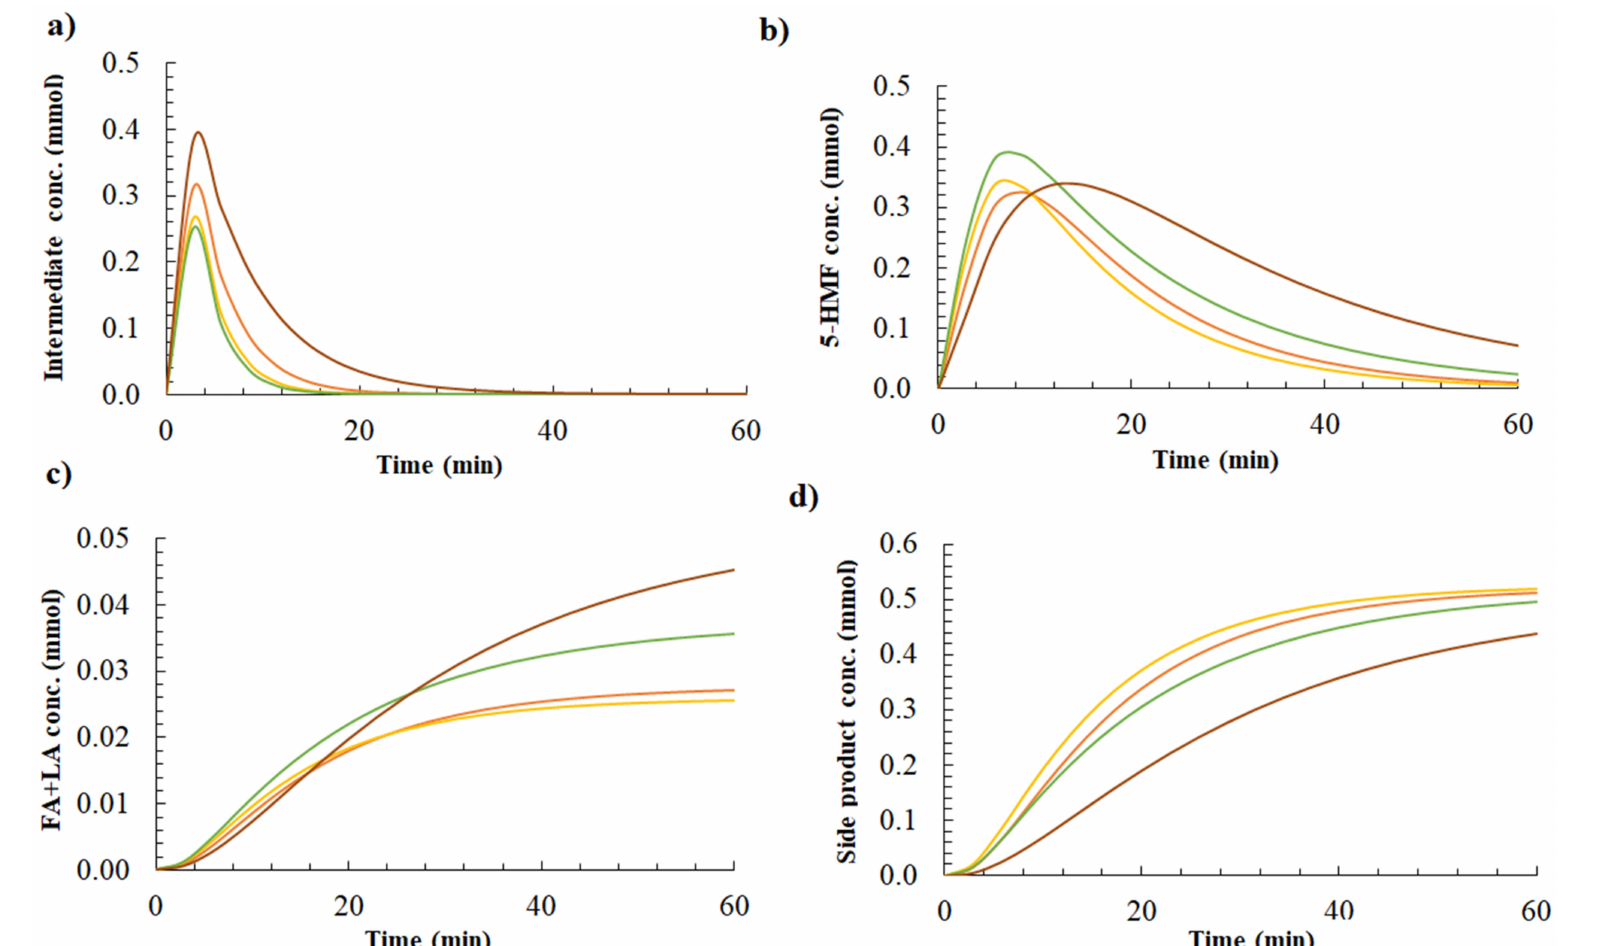
Figure 6. Predicted concentration profiles of acid-catalyzed fructose dehydration using MW heating: ( a ) intermediate formation, ( b ) 5-HMF production, ( c ) LA + FA production, ( d ) side product formation. Symbols denote simulated values at ( — ) 140 ◦ C, ( — ) 150 ◦ C, ( — ) 160 ◦ C, and ( — ) 170 ◦ C with 3 mL solvent, 10 mg MIL-101(Cr)-SO 3 H(3), and 100 mg fructose (0.56